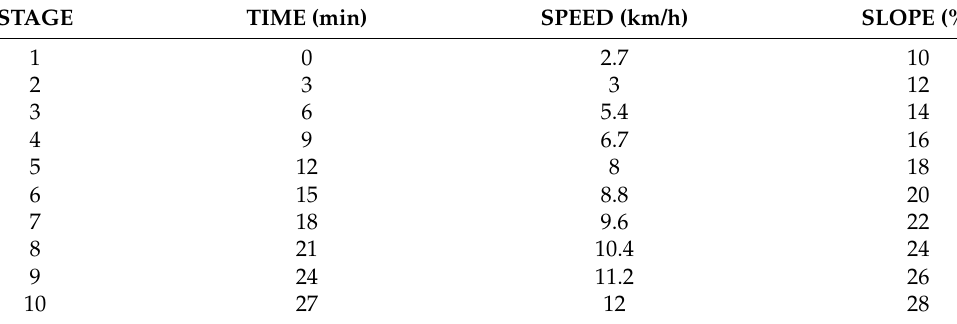
Table 1. Details of speed and slopes used in each stage of Bruce